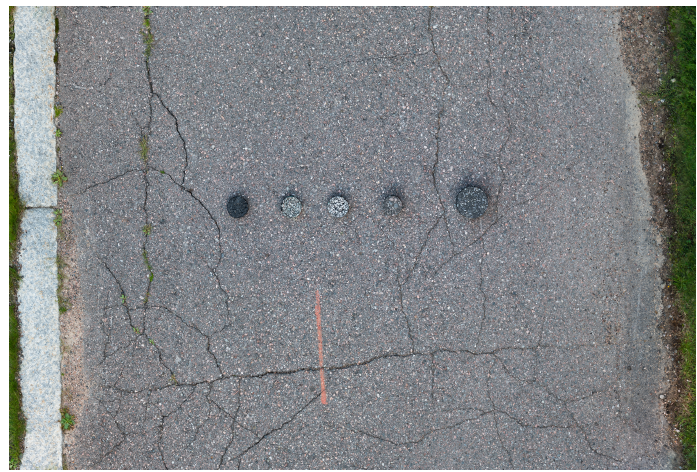
Figure 3. Reference measurement setup. Samples are in ID order 1–5 from left to